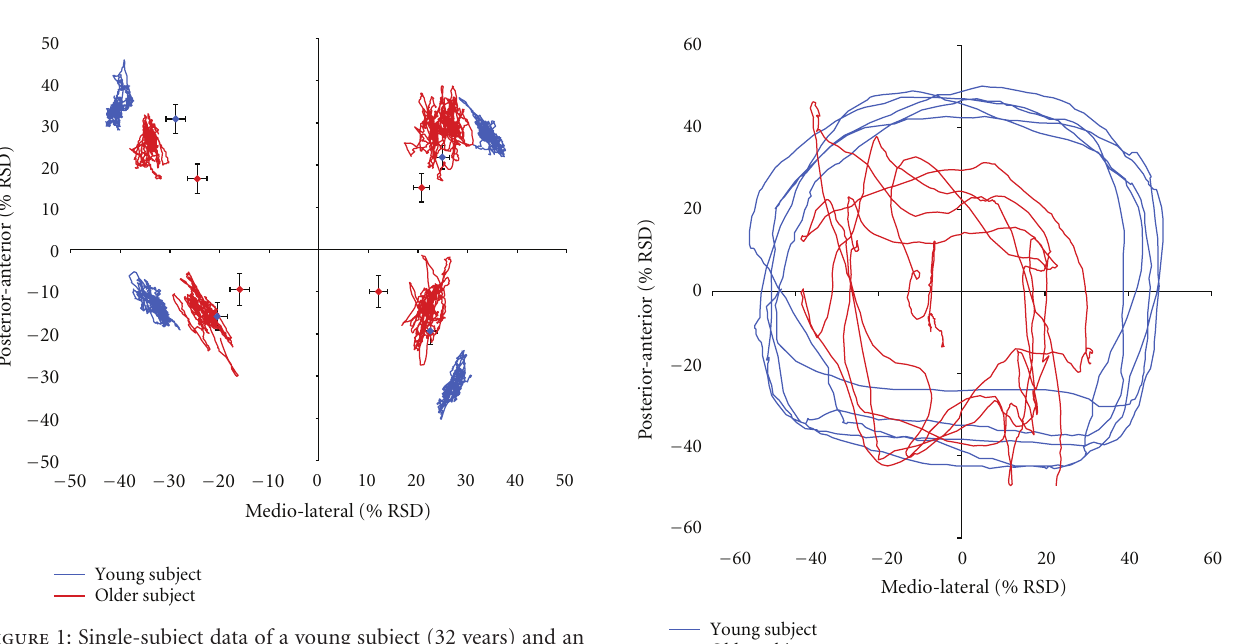
(Figure 3). The average radius of all sectors per